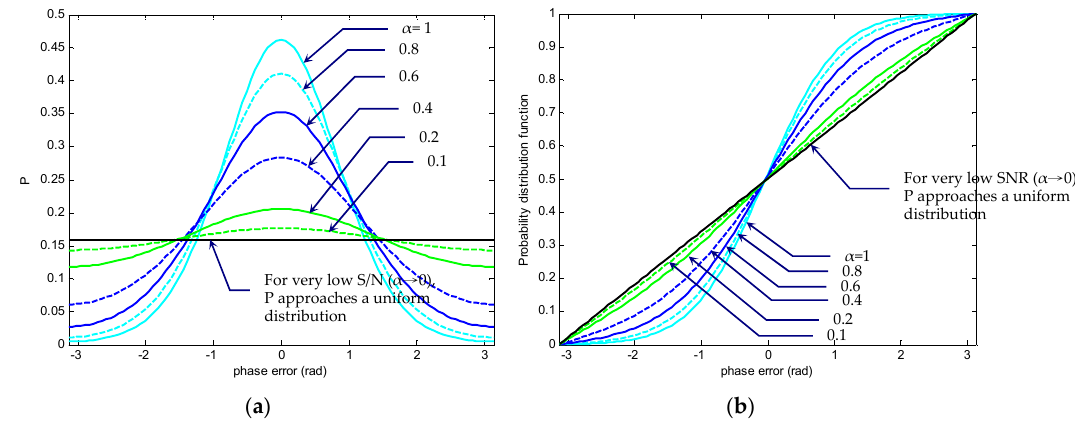
Figure 19. Variation of modulo-2 π phase-error steady state: ( a ) PDF and ( b ) cumulative probability distribution function at τ = 0.625 for various SNR values ( γ = 0).